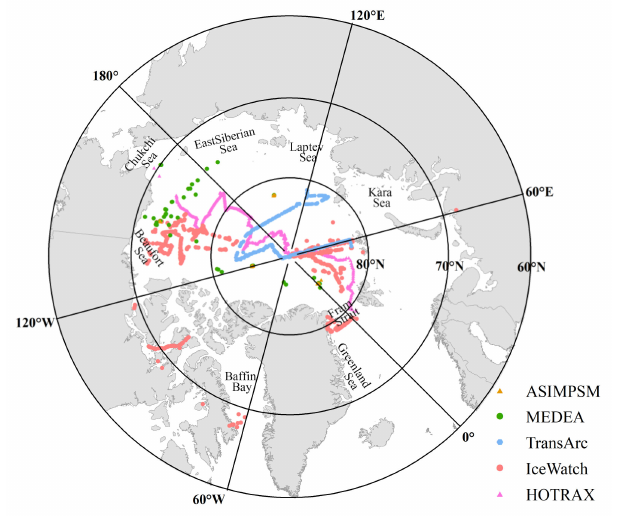
Figure 1. Spatial distributions of the validation datasets used in this